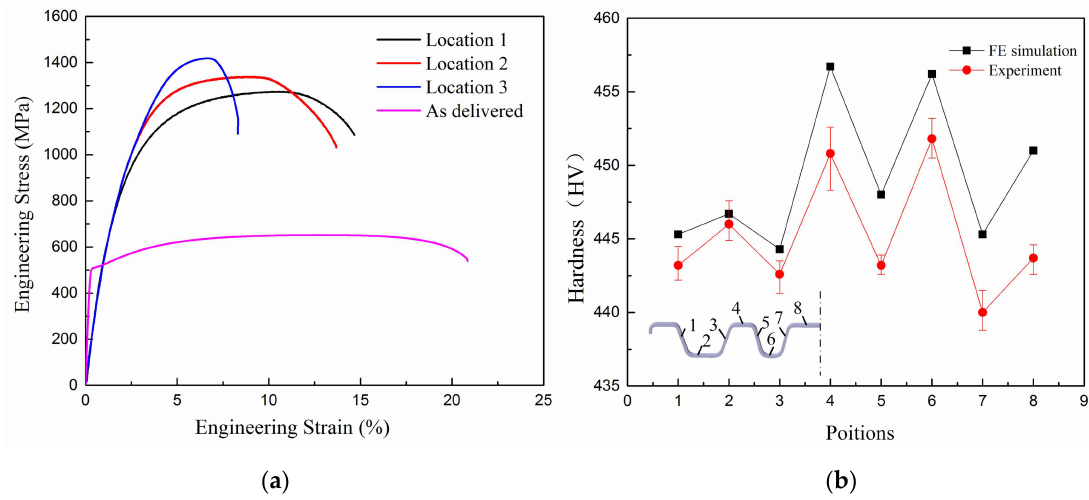
Figure 11. Engineering stress-strain curves ( a ) and hardness distribution of part ( b ).